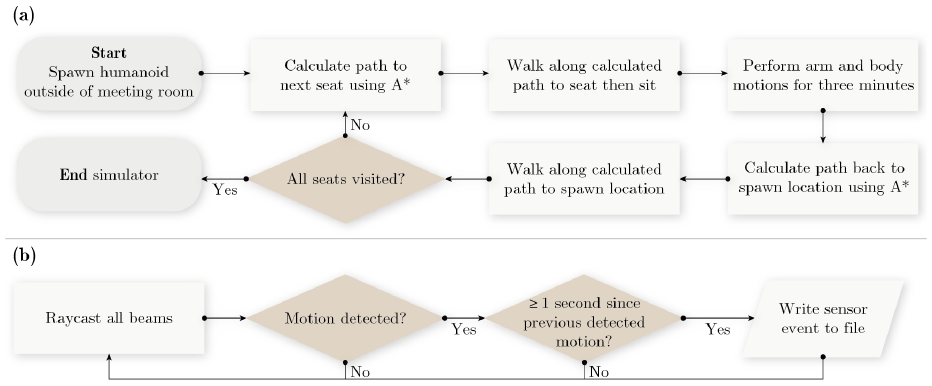
Figure 6. Flowcharts of the simulator developed for Study A. The upper flowchart, ( a ), describes the software logic of the humanoid. The lower flowchart, ( b ), describes the software logic of each individual motion sensor in the room. During the simulation both parts of the software are running